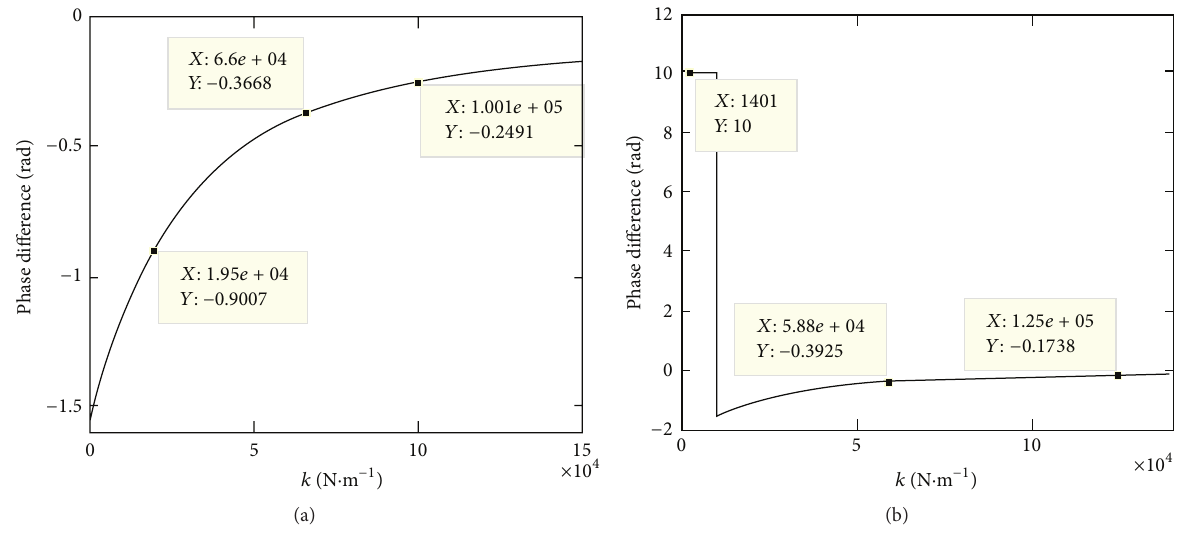
Figure 4: Stable phase difference is changed with the stiffness of the connecting spring for (a) 𝑛 𝑥 = 𝑛 𝑦 = 𝑛 𝜑 = 5.817 ; (b) 𝑛 𝑥 = 𝑛 𝑦 = 𝑛 𝜑 = 6.704 ; In this figure, coordinate X represents the stiffness of the connecting spring; coordinate Y represents the phase difference (𝛼) of co-rotating motors; 𝛼 = 10 [rad] shows that there is no stable